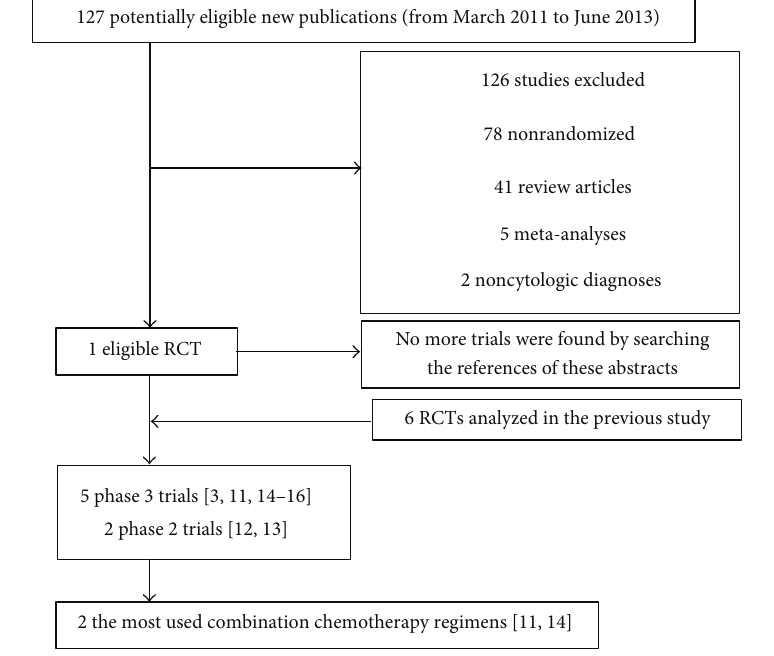
Figure 1: The flow chart.